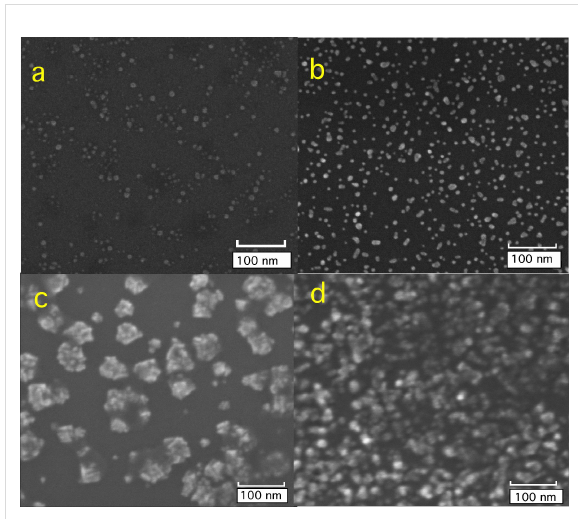
Figure 1: SEM images taken from (a) bare Ag NP deposited on Si/SiO x substrates with t Ag = 0.8 nm (given in equivalent thickness), (b) bare Ag NPs, with t Ag = 1.5 nm, (c) Ag NPs co-deposited with Mg in O atmosphere with t Ag = 0.8 nm/ t MgO = 1.3 nm, (d) Ag NPs co-deposited with Mg in O atmosphere t Ag = 3.3 nm/ t MgO = 4.8